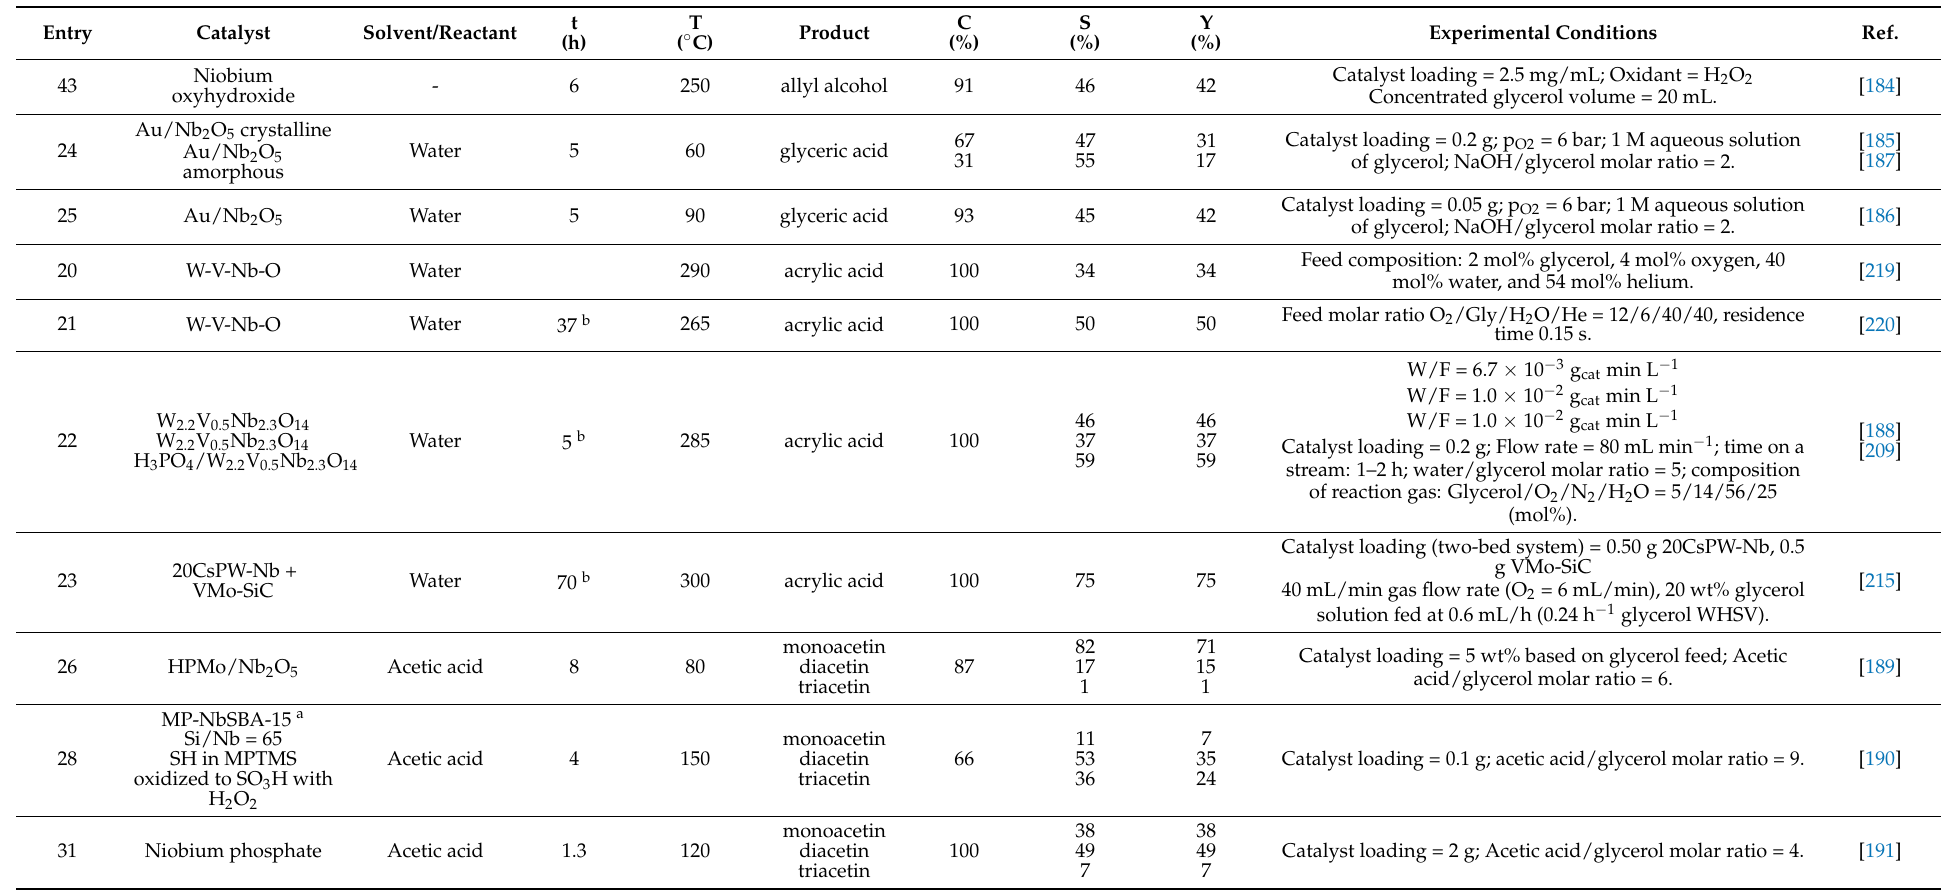
Table 7. Performance of niobium-based catalysts for conversion of glycerol into different products—from 2010 to